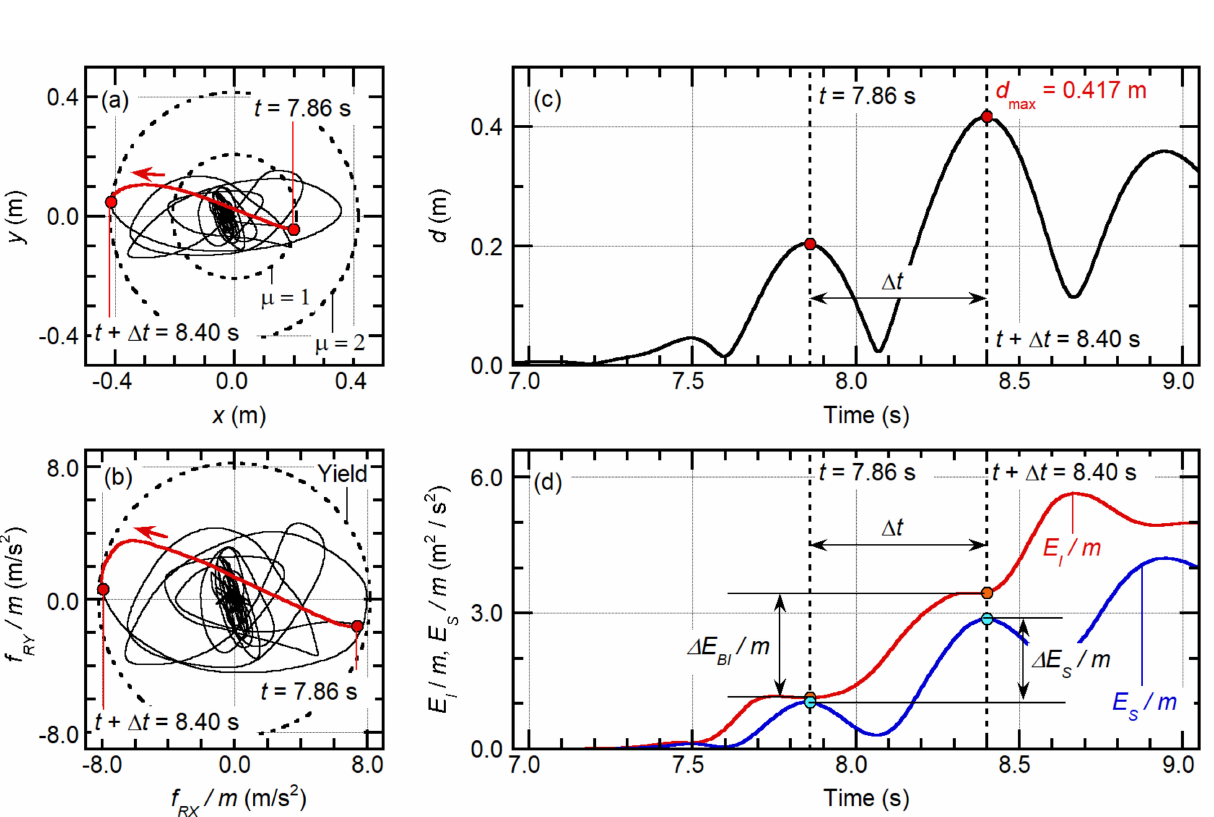
Figure 2. Definition of maximum momentary input energy for bidirectional excitation: ( a ) orbit of response displacement; ( b ) orbit of response restoring force; ( c ) time-history of absolute displacement; ( d ) time-history of input energy per unit mass and cumulative strain energy per unit